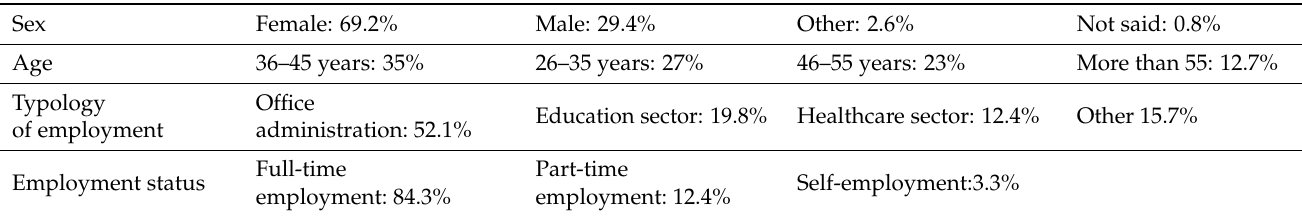
Table 1. Research sample: demographic and occupational characteristics.